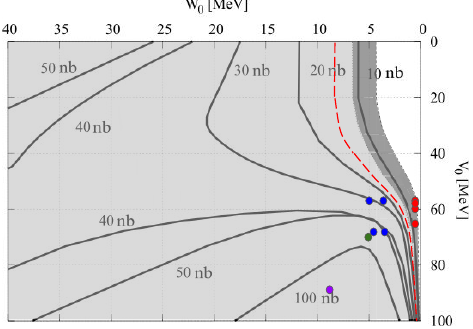
Figure 3. Contour plot of the theoretically determined conversion cross section in the V 0 − W 0 plane [8]. The light shaded area shows the region excluded by our analysis, while the dark shaded area denotes the systematic uncertainty of the σ CL = 90% . The red line extends the allowed region based on a new estimate upp of errors (see text for details). Dots correspond to the optical potential parameters corresponding to the predicted η -mesic 4 He states. Figure is adopted from Ref.